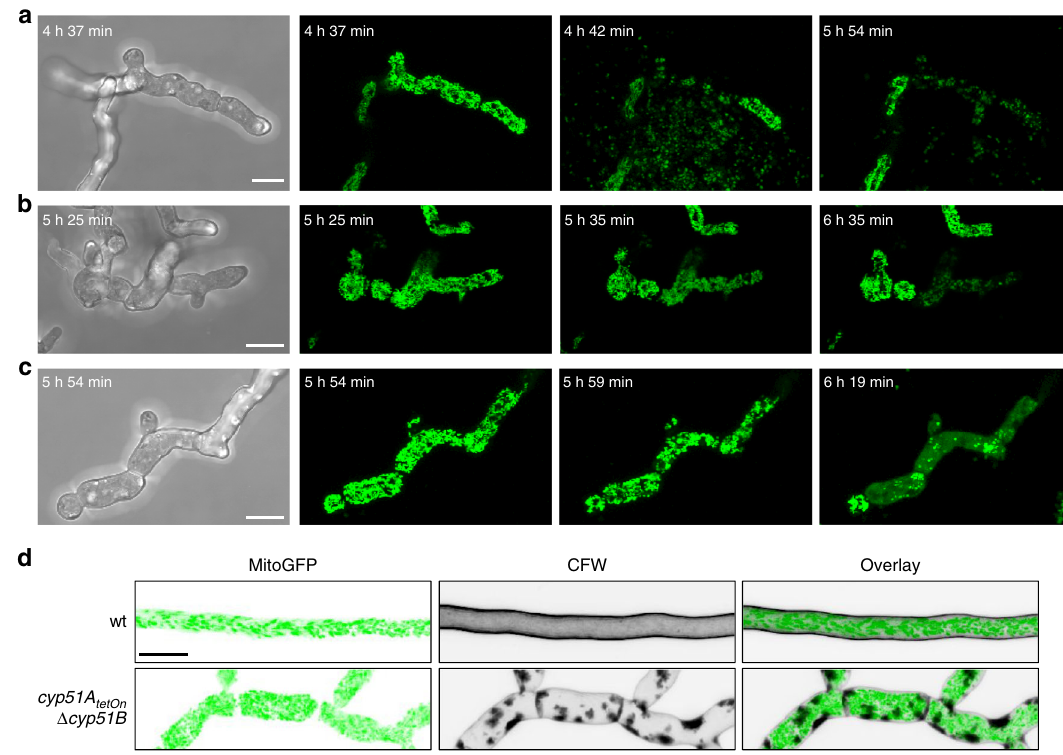
Fig. 3 Azole-triggered cell death and synthesis of cell wall carbohydrate patches are linked to inhibition of the lanosterol 14 α -demethylase. a – d Conidia of the conditional cyp51A tetOn Δ cyp51B strain ( a – d ) and wild-type ( d ) that express mitochondria-targeted GFP were inoculated under induced conditions in Sabouraud medium supplemented with 15 µ g ml − 1 doxycycline. After 9 h incubation at 37 °C, hyphae were shifted to repressive conditions by substitution of the medium without doxycycline. a – c The fate of individual hyphae was followed over time with a confocal laser scanning microscope. Depicted are exemplary bright fi eld and time-lapse GFP fl uorescence images (green) of optical stacks covering the entire hyphae in focus. d After 5 h incubation under repressive conditions, hyphae were fi xed, stained with calco fl uor white and subjected to confocal laser scanning microscopy. Depicted images represent optical stacks of GFP fl uorescence (left panels), calco fl uor white fl uorescence (middle panels) and an overlay (right panels) that cover the entire hypha in focus. a – d Bars represent 10 μ m and are applicable to all